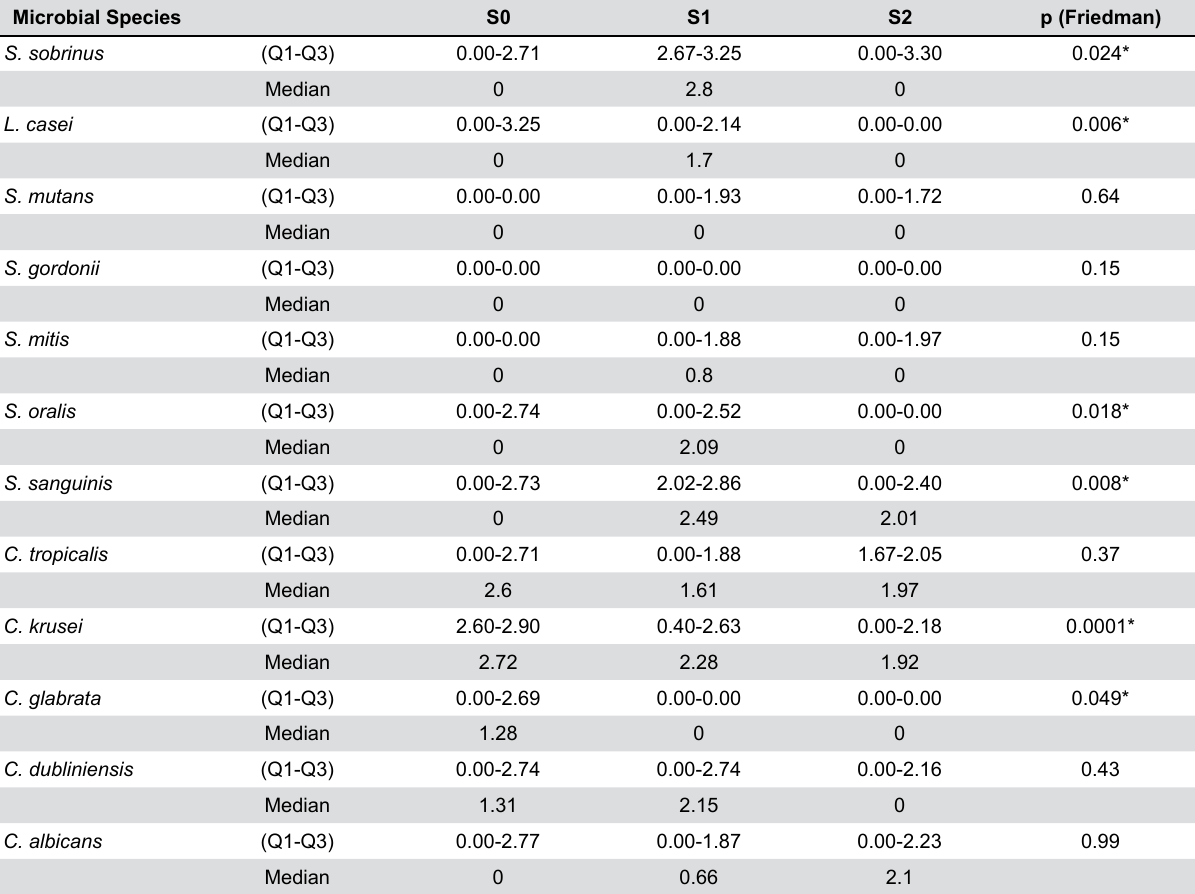
Figure 3- Demographic characteristics and malocclusion features of the Table 1- Microbial count (µg x 10 5 ) in the saliva